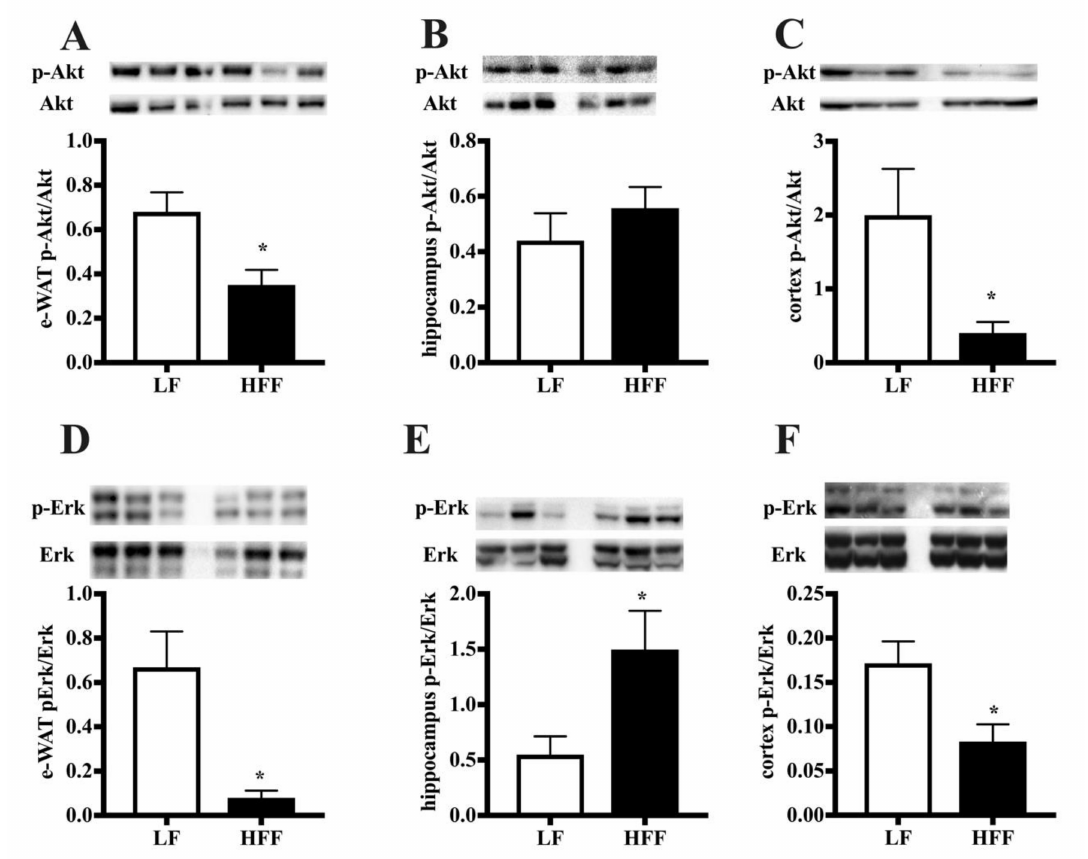
Figure 8. Protein content (with representative western blot) of phosphorylated Akt (p-Akt) and Erk (p-Erk) in epididymal white adipose tissue (e-WAT) ( A , D ), hippocampus ( B , E ), and frontal cortex ( C , F ) from middle-aged rats fed low fat (LF) or high fat-high fructose (HFF) diets for four weeks. Values are the means ± SEM of eight rats. * p < 0.05 compared to low-fat diet (two-tailed Student’s